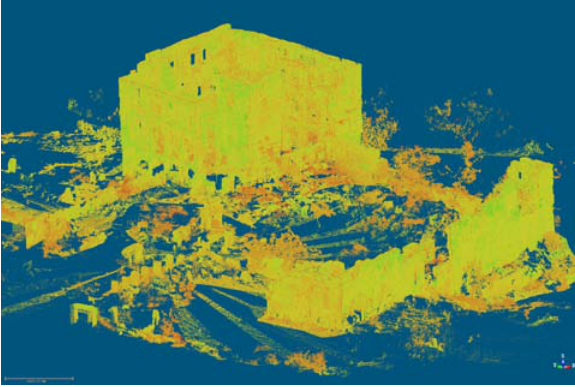
Figure 17. The final point cloud of the “Résidence”.